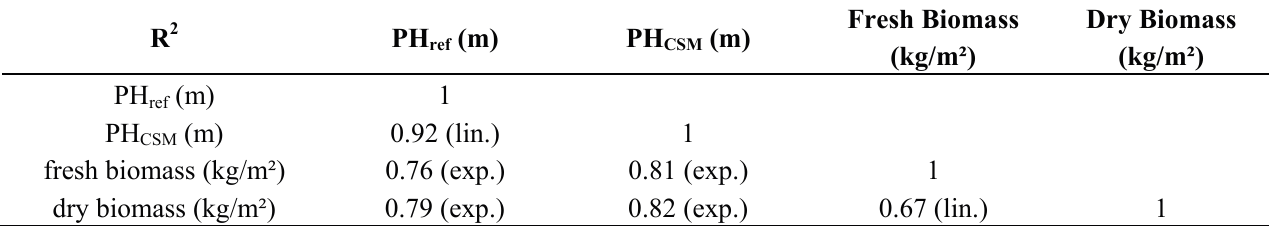
Table 3. Coefficients of determination ( R 2 ) for PH (CSM and ground reference, linear regression) and above-ground fresh and dry biomass (exponential regression) for all